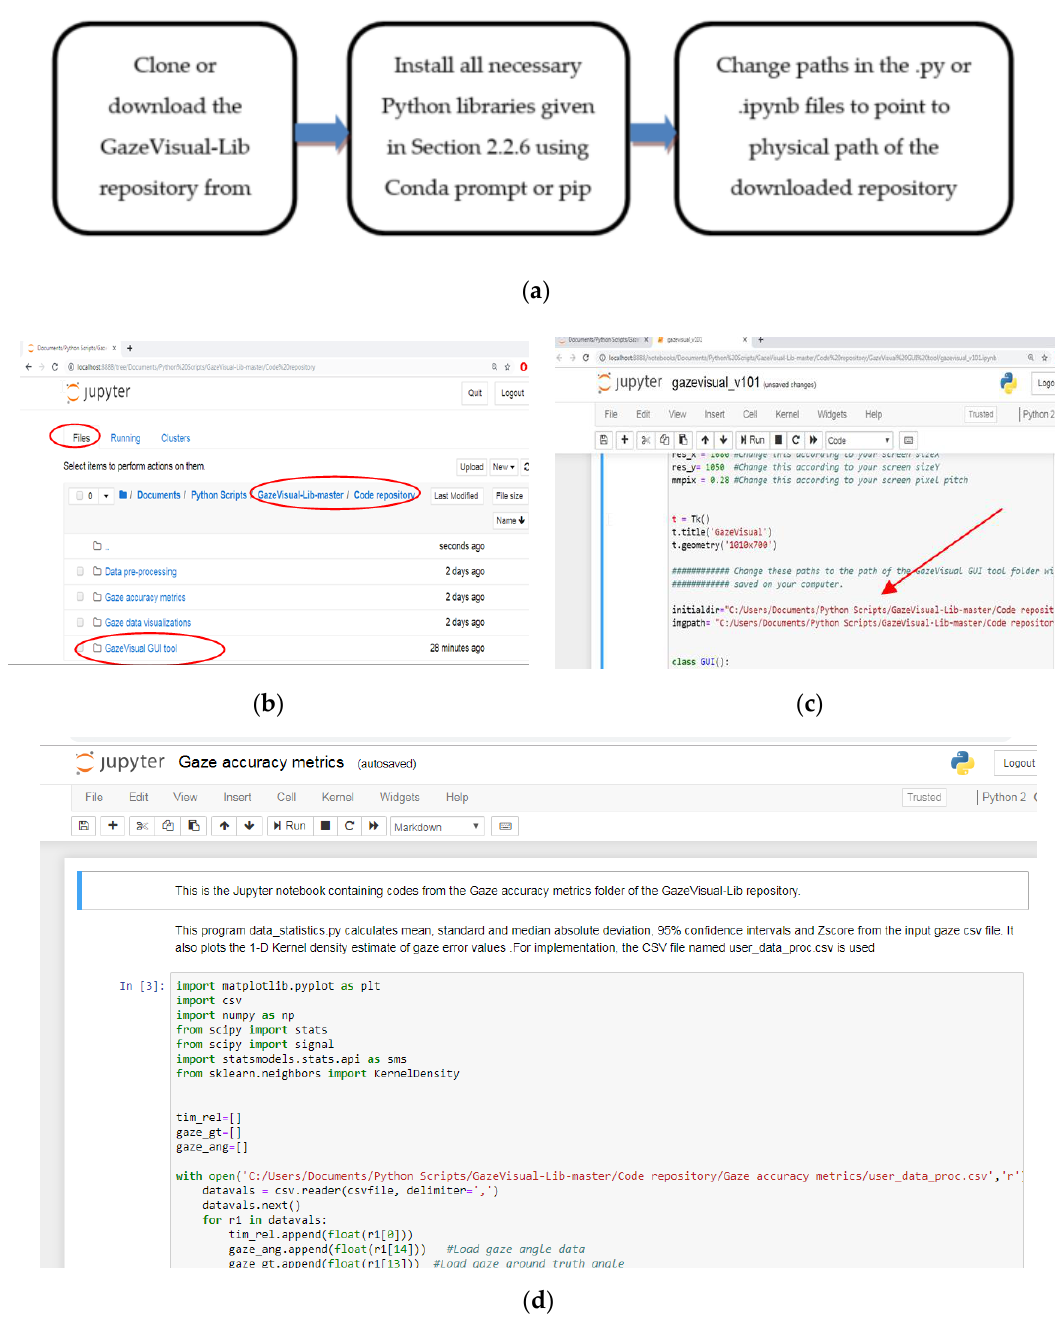
Figure 9. ( a ) Flowchart for running the GazeVisual-Lib codes. ( b ) Opening the Jupyter Dashboard to locate the downloaded GazeVisual-Lib folder. ( c ) Running the GazeVisual GUI code on Jupyter (arrow shows the paths which have to be changed). ( d ) View of the Jupyter notebook for the Gaze accuracy metrics folder.